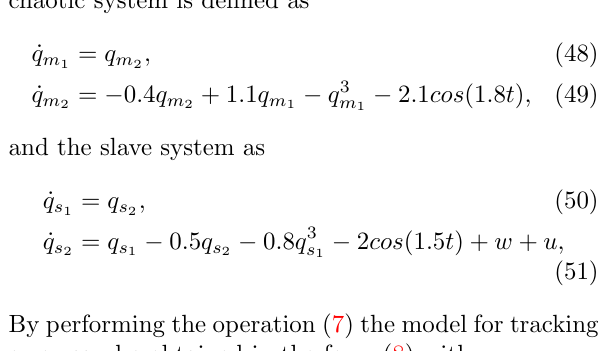
Figure 7: Measured γ according to ω